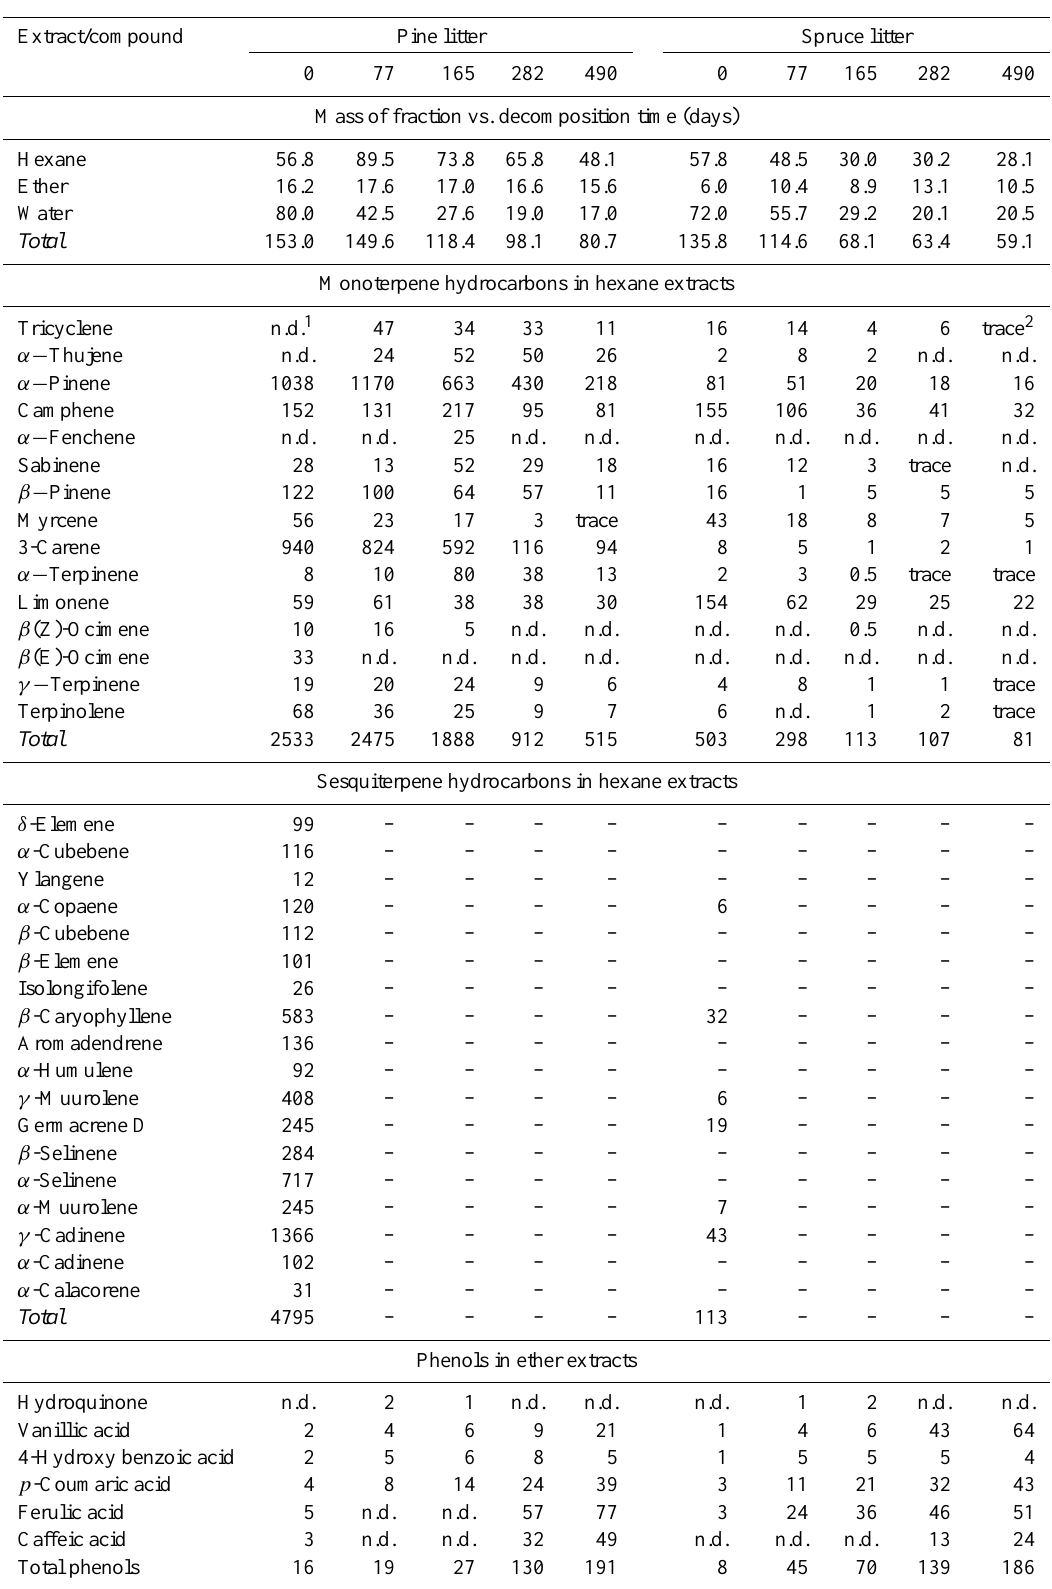
Table 2. Changes of the fractional composition of extracts and mean concentrations [ µgg − 1 (dw) ] of selected compounds in decomposing Scots pine and Norway spruce